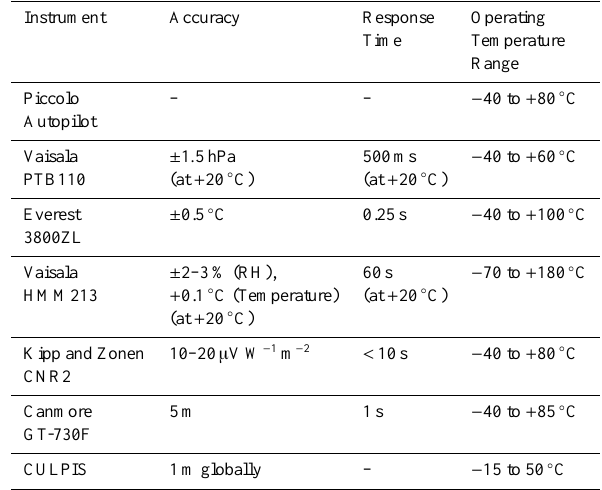
Table 2. Instrument specifications for the equipment carried on board the